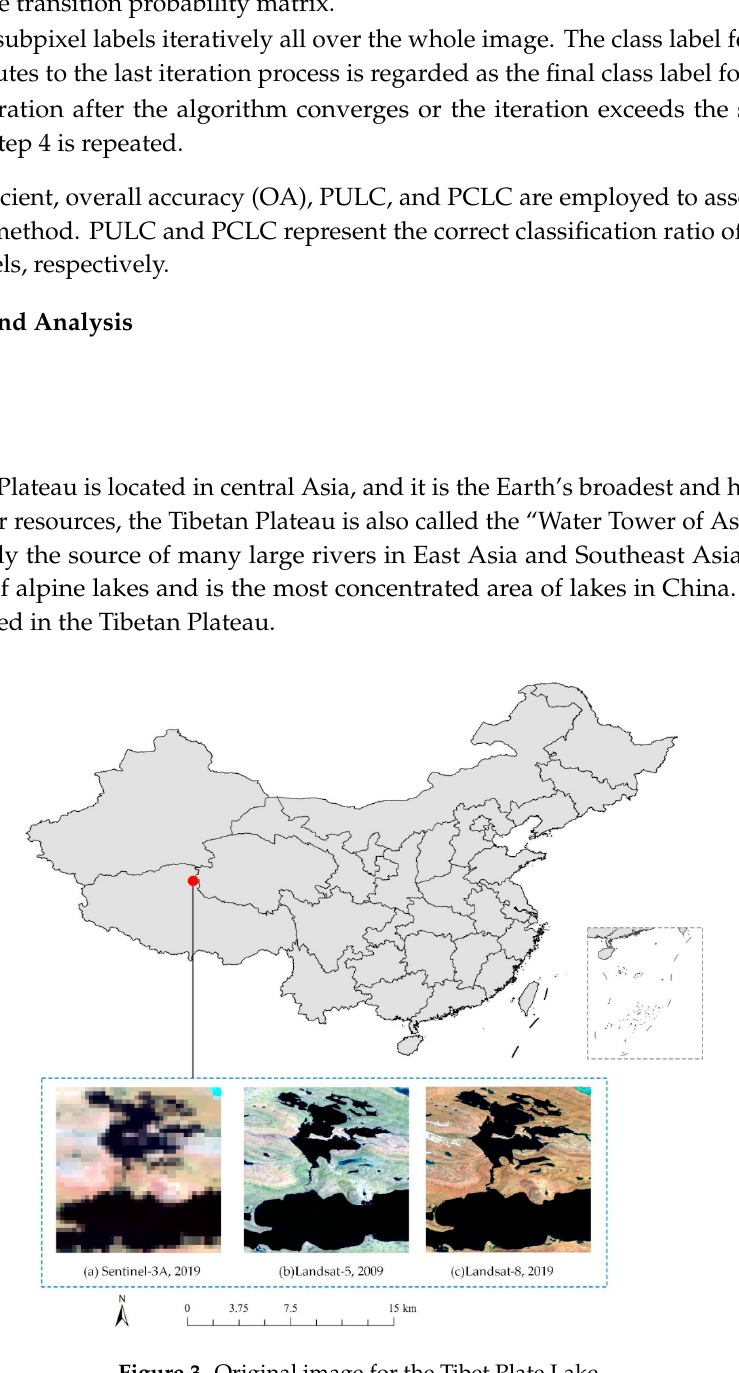
Figure 3. Original image for the Tibet Plate Lake.